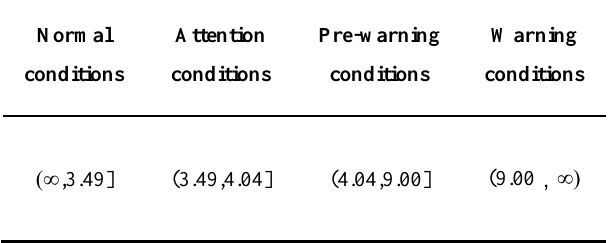
Table 7 The thresholds values of wind speed